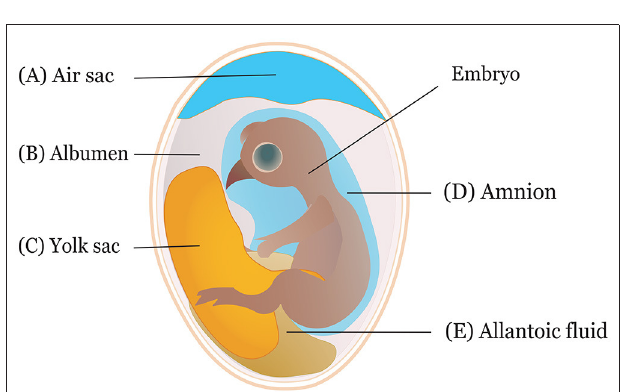
FIGURE 2 | Sites of in ovo inoculation. Eggs can be inoculated through (A) air sac, (B) albumen, (C) yolk sac, (D) amnion, and (E) allantoic